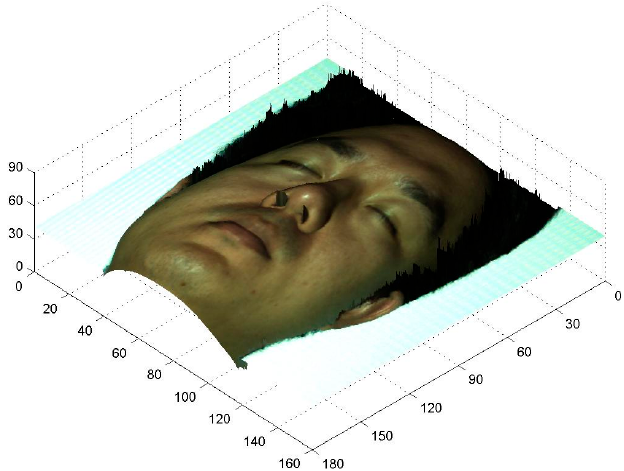
Figure 12. 3D curved surface rebuilt based on the texture mapping technique (Scale: mm).